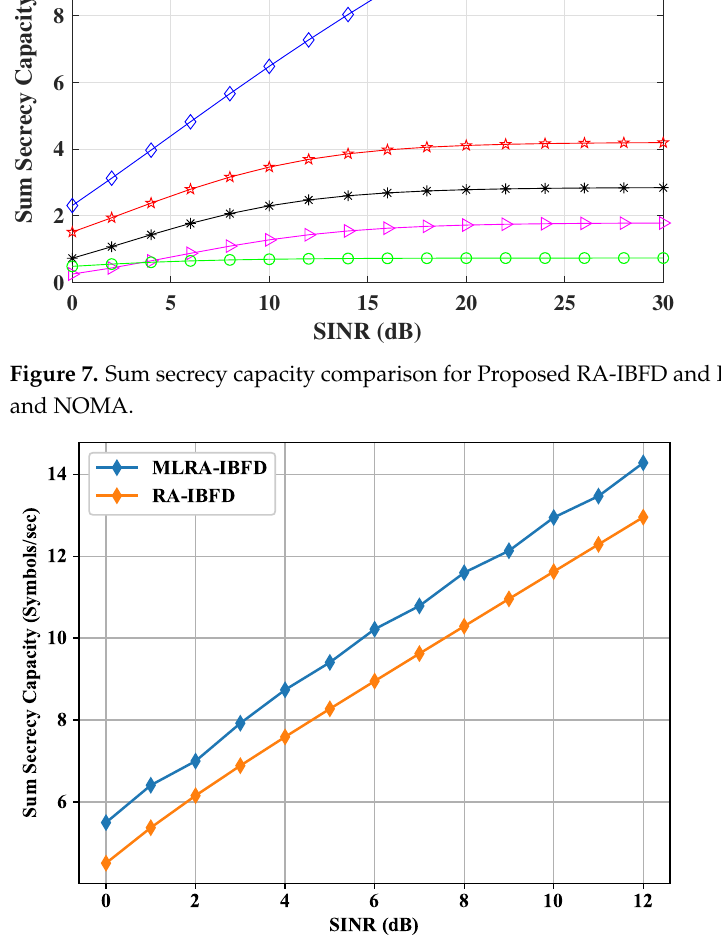
Figure 8. Sum secrecy capacity comparison for Proposed RA-IBFD with and without